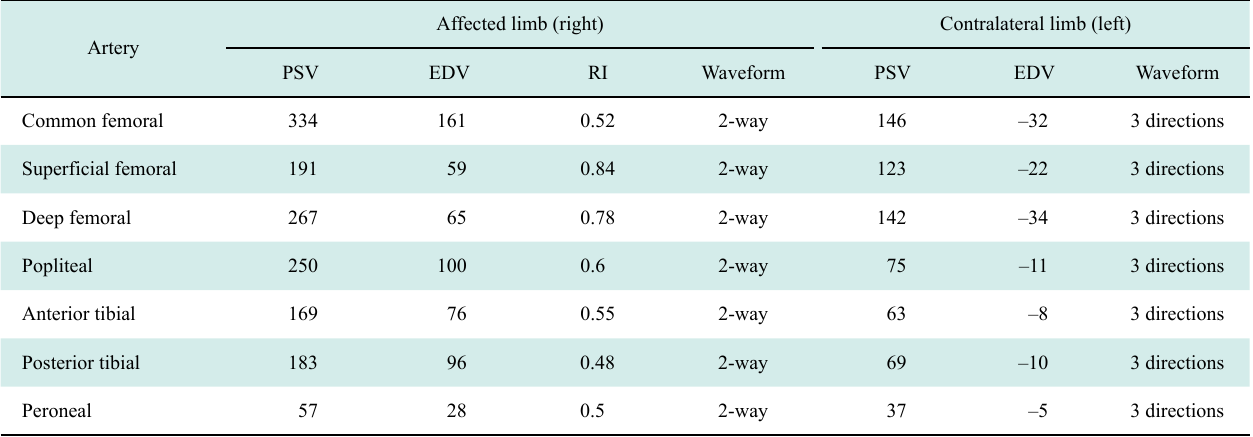
Table 2 Doppler ultrasound, blood flow parameters in the lower limbs (velocity, cm/s) Artery